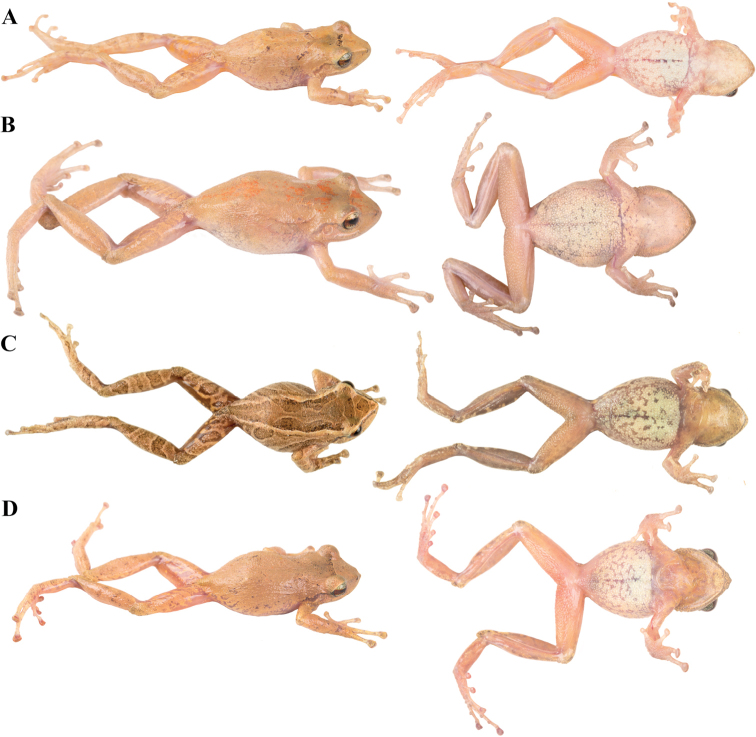
Color variation in live individuals of Pristimantis
torresi sp. nov. AQCAZ 64524 (male, SVL 26.7 mm) BQCAZ 65767 (female, SVL 35.8 mm) CQCAZ 65771 (male, SVL 28.7 mm) DQCAZ 65779 (male, SVL 26.4 mm). Dorsolateral view on the left, ventral view on the right.